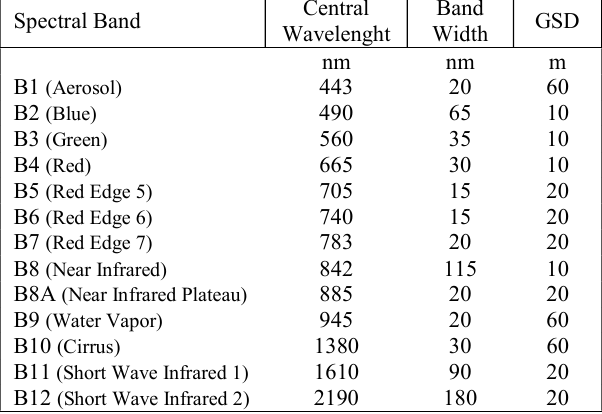
Table 1 . S2 MSI bands technical specifications: central wavelength, band width and ground sample distance (GSD).